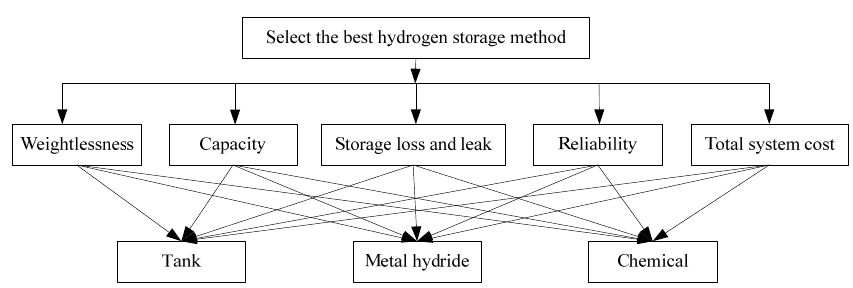
Figure 2. The HES method selection hierarchy.